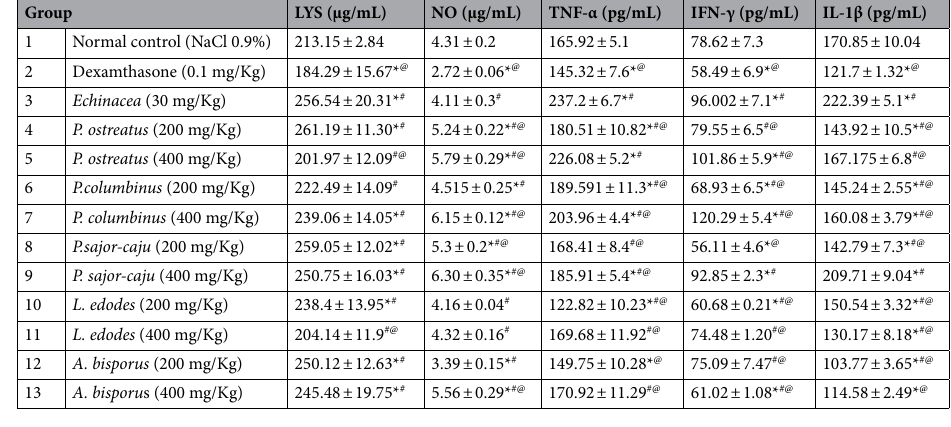
Table 2. Immunomodulatory serum biomarkers of the tested mushroom extracts as compared to controls. Data are mean ± SD (n = 6). LYS lysozyme, NO Nitric oxide, TNF-α tumor necrosis factor alpha, IFN-γ Interferon gamma, IL-1β interleukin 1 beta. * Significantly different from normal control group, # significantly different from dexamethasone control group, @ significantly different from Echinacea extract treated group at P ≤